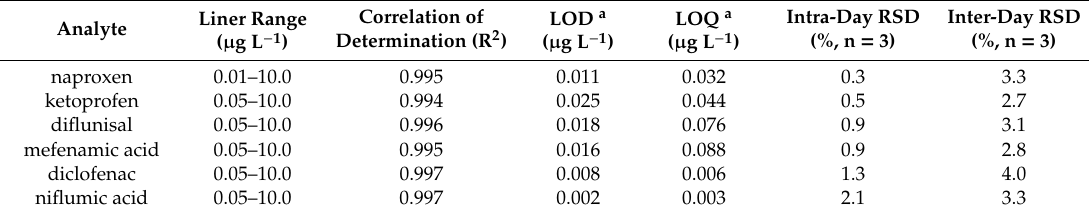
Table 3. Liner regression, LODs, LOQs, and RSDs data for the poly(DEAEMA-co-DVB) based WAX SPE/HPLC-UV method.